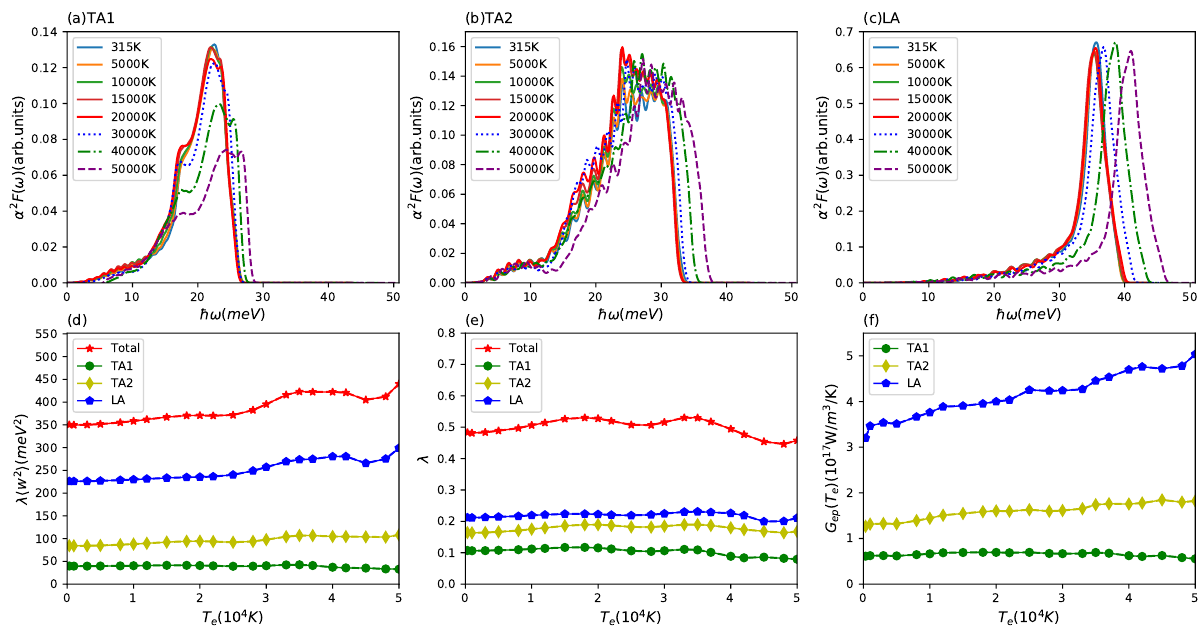
Figure 3. Results for aluminium. Eliashberg function α 2 F ( ω ) of partial branches of ( a ) TA1, ( b ) TA2, and ( c ) LA at different electron temperatures; ( d ) second moment of Eliashberg function λ (cid:104) w 2 (cid:105) and ( e ) electron–phonon coupling constant λ for total and three different branches (TA1, TA2, LA) with increasing electron temperature; ( f ) electron temperature-dependent electron–phonon coupling factor G ep ( T e ) for three partial branches (TA1, TA2, LA).